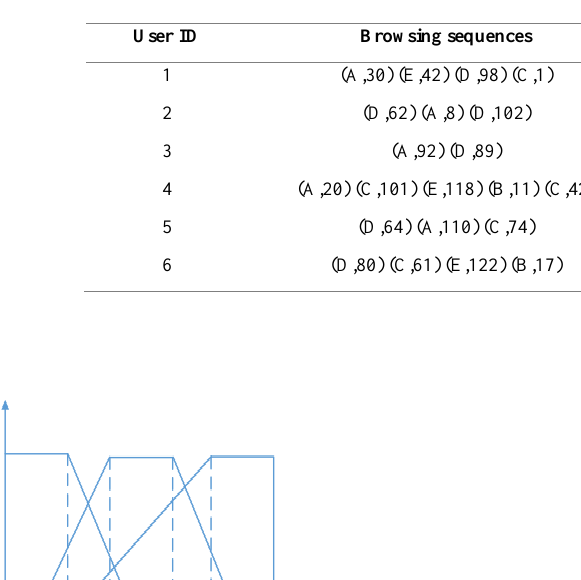
Table 1. Browsing sequences by each user.